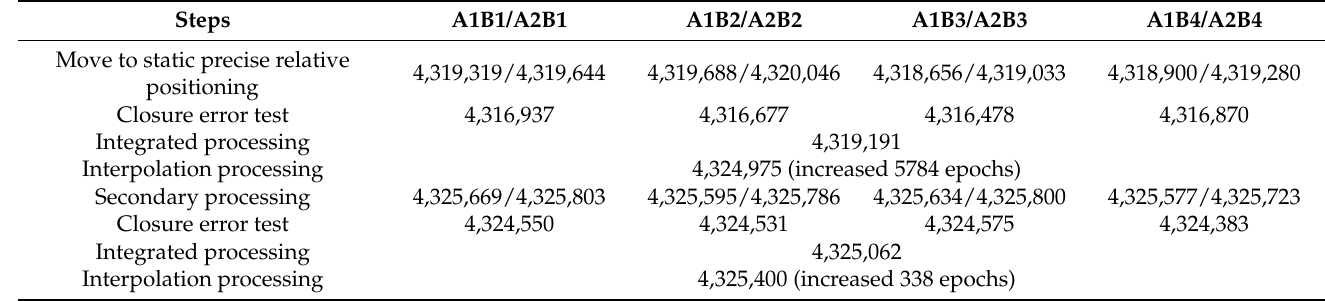
Table 2. Number of effective epochs after each processing